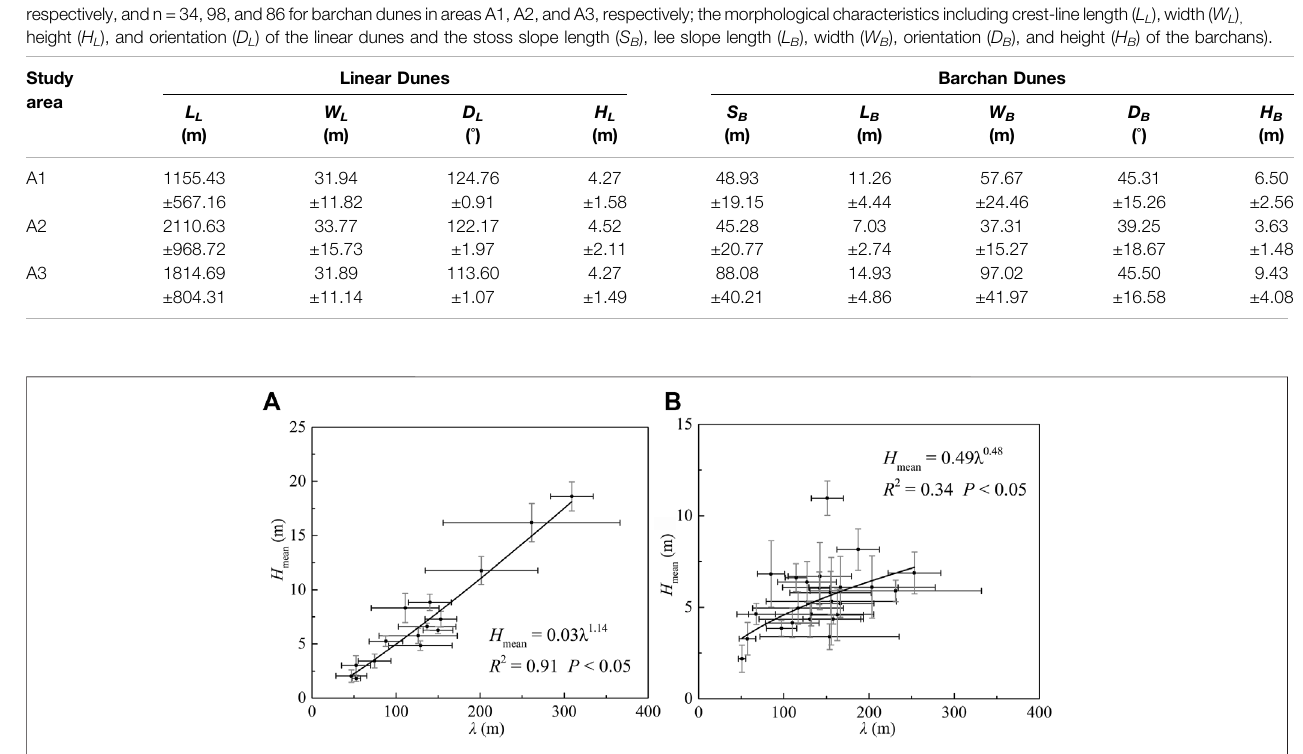
FIGURE4| Therelationshipsbetweenaverageduneheight( H mean )oftwoadjacentdunesandthespacingbetweencrests( λ )intheareaswhere (A) barchansand (B) linear dunes coexisted. Values are means ± SD.